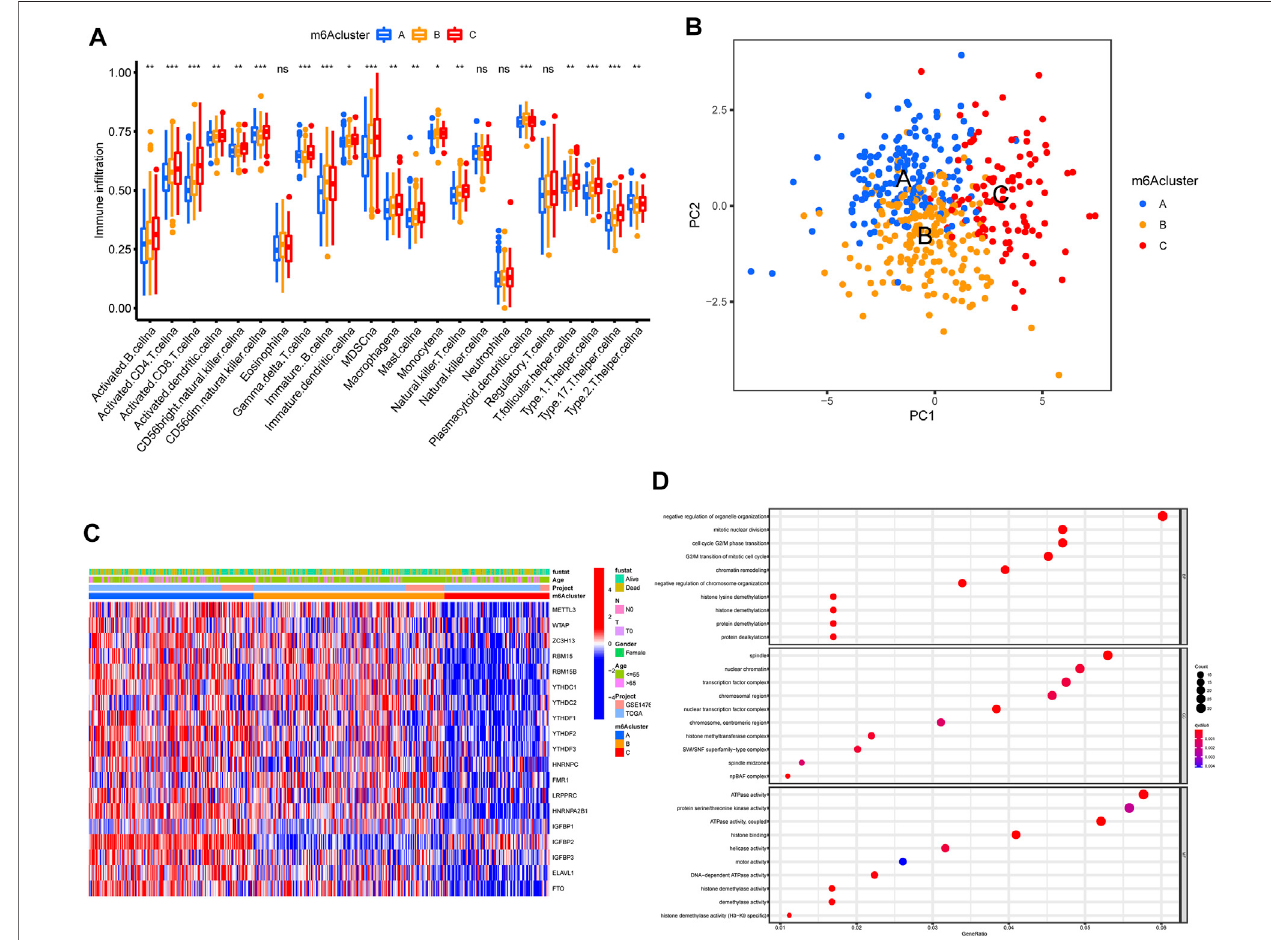
FIGURE4| TMEcellin fi ltrationcharacteristicsandtranscriptometraitsindistinctm6Amodi fi cationpatterns. (A) TheabundanceofeachTMEin fi ltratingcellinthree m6A modi fi cation patterns. (B) Principal component analysis for the transcriptome pro fi les of three m6A modi fi cation patterns, showing a remarkable difference on transcriptome between different modi fi cation patterns. (C) Unsupervised clustering of m6A regulators according to TCGA and GSE14764 cohort. (D) Functional annotation for m6A-related genes using GO enrichment analysis.